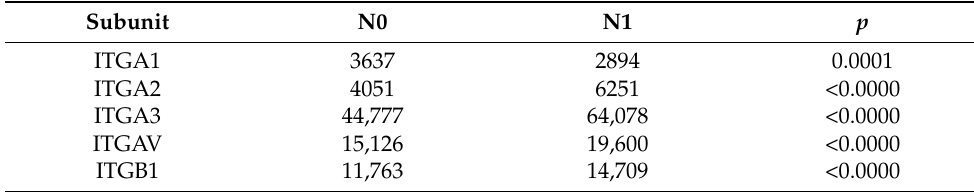
Table 3. Mean gene expression and Wilcoxon analysis for lymph node metastasis. Only significant data are reported.